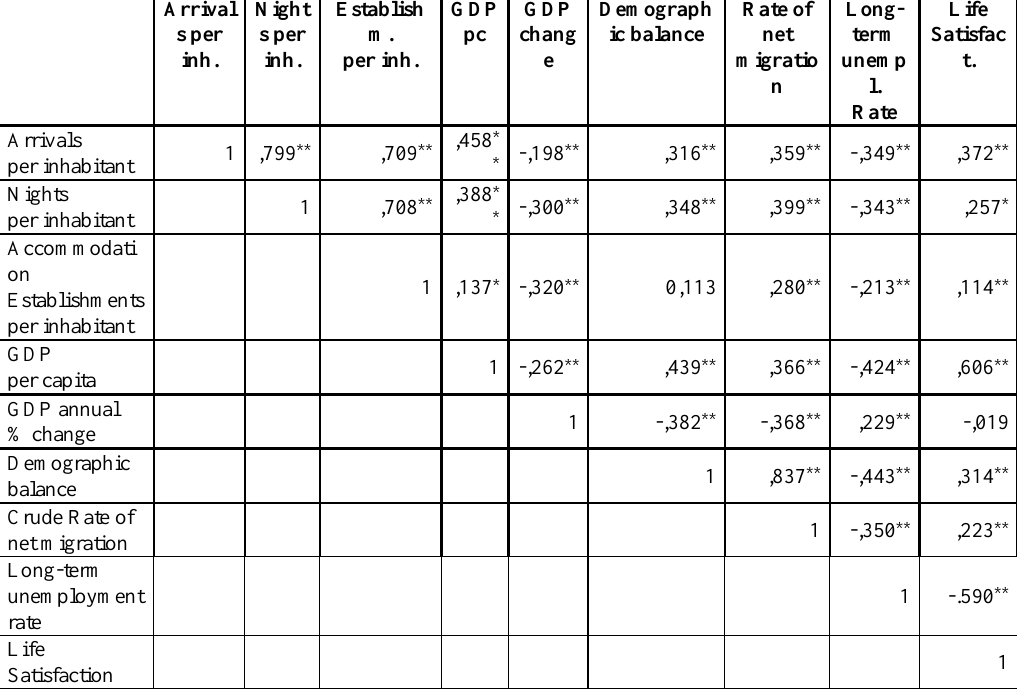
Table 4 : The relationships among tourism and socio-economic development indicators (correlation matrix; average